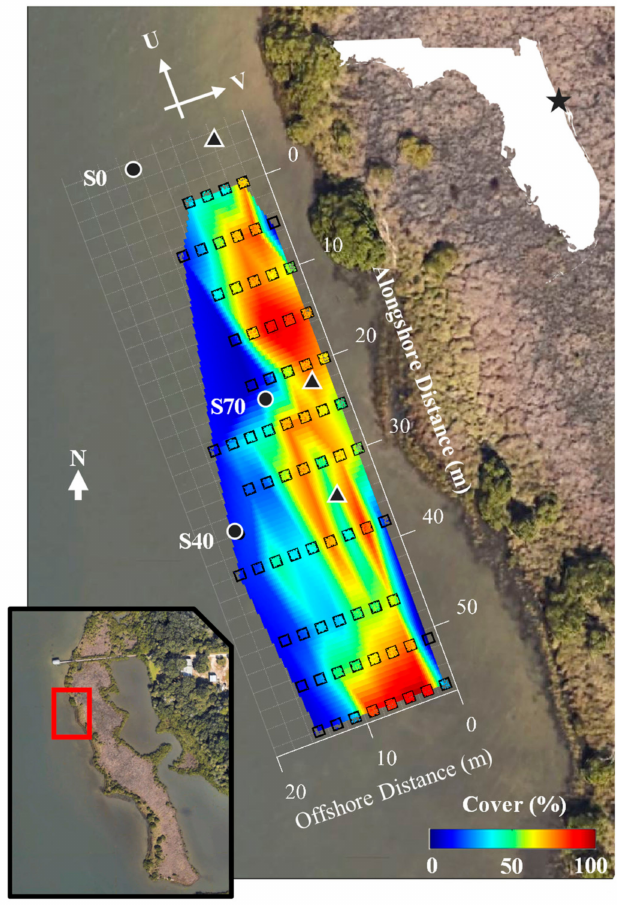
Figure 1. Site map and observed seagrass densities. The relative location of each deployment (S0, S40, S70) is indicated (circles: Aquadopp HR; triangles: Vectrino), along with a colormap indicating the local seagrass cover. Seagrass was observed south of the surveyed region, but not surveyed in detail. The channelwise ( U ) and cross-shore ( V ) velocity convention is included for reference. The inset map shows the survey location along the shoreline of Mosquito Lagoon (Florida, USA: white outline), including a dock approximately 75 m north of the northernmost sample location. Table 1. Summary of seagrass characteristics for vegetated sample sites. Minimum and maximum lengths for individual seagrass blades are shown in curly brackets ({}), and ± symbols indicate 95% confidence intervals on sample means. Estimated blade diameters ( d ) were approximately 1